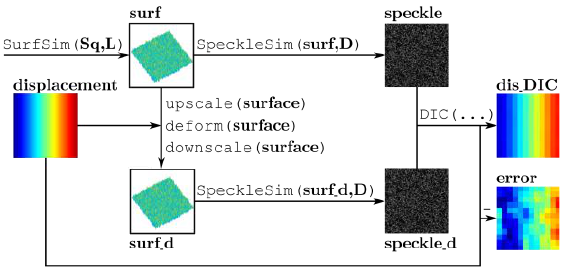
Fig. 1. Speckle simulation